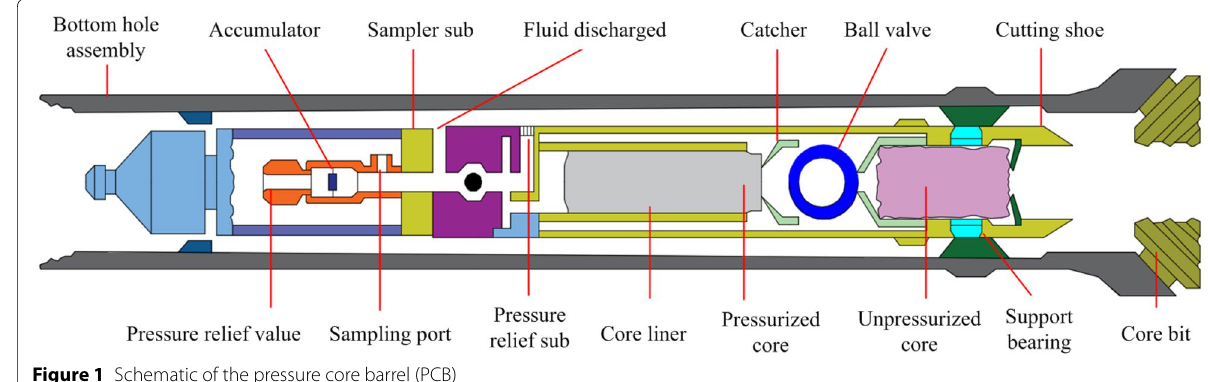
Figure 1 Schematic of the pressure core barrel